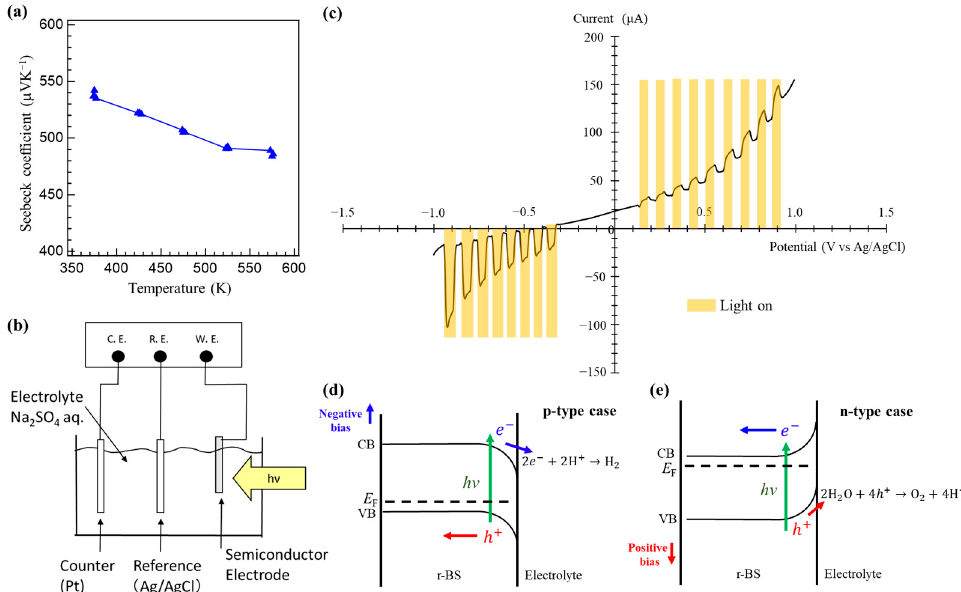
Figure 3. p-type property of the synthesized r-BS. ( a ) Temperature dependence of the Seebeck coefficient of the synthesized r-BS. ( b ) The experimental system used for the photoelectrochemical measurements. ( c ) Photoelectrochemical measurements of r-BS. Linear sweep voltammetry (LSV) was conducted with and without light irradiation. Schematic expected energy diagrams and photoelectrochemical reactions in the case that ( d ) r-BS is a p-type semiconductor and the case that ( e ) r-BS is an n-type semiconductor.